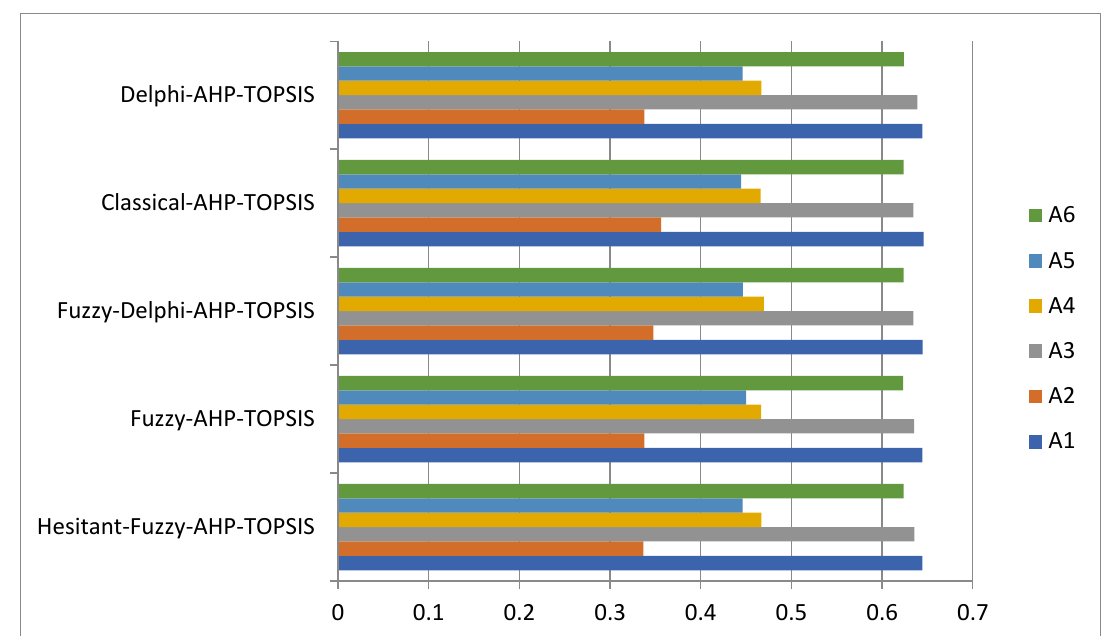
Figure 7. Graphical representation of comparative analysis.